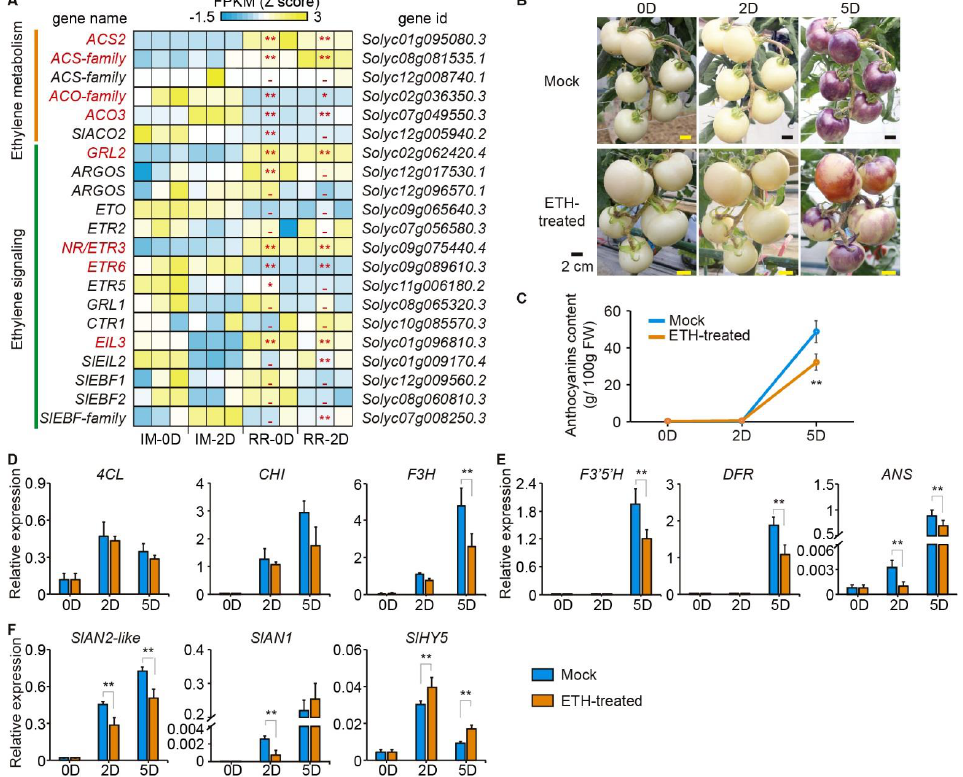
Figure 5. Effects of ethylene on anthocyanin accumulation and biosynthesis. ( A ) Expression profiles (FPKM, Z score) of the ethylene-related genes. Student’s t -test, n = 3; ** p < 0.01 and * p < 0.05 indicate statistically significant differences between immature and red ripening fruits. Fruit phenotype ( B ), anthocyanin content ( C ) and the relative expression levels of EBGs ( D ), LBGs ( E ), and regulators ( F ) in the ETH-treated and mock fruits before (OD) and after (2D and 5D) removing bags. Expression analysis was performed by qRT-PCR with ACTIN as the reference gene. Data are presented as the mean ± SD of three biological replicates. Asterisks indicate significant differences between immature and red ripening fruits, as determined by Student’s t -test (** p < 0.01). ETH, ethephon.